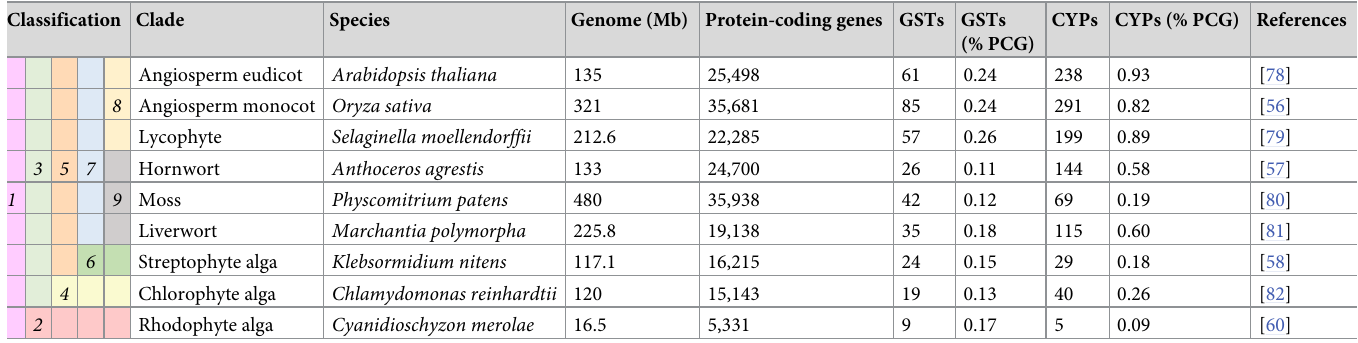
Table 1. List of species used in the analysis.